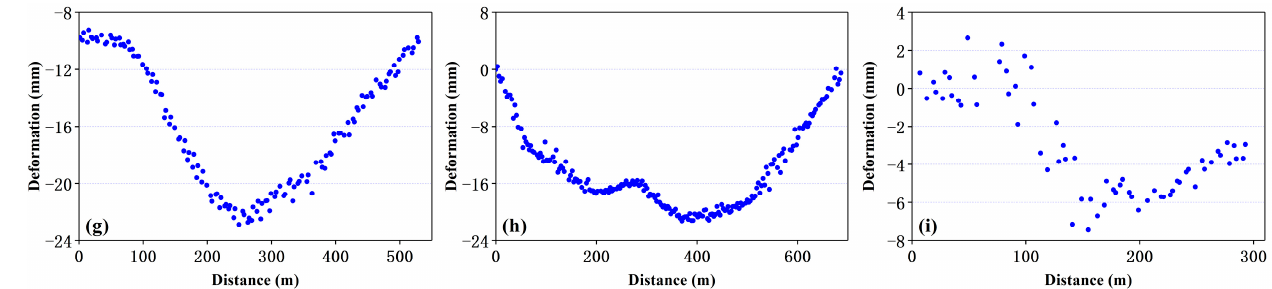
Figure 9. Land deformation rate and time series of three subsidence area. ( a – c ) is Santa Ana Basin, Pomona–Ontar Basin, and San Bernardino Basin; ( d – f ) Corresponding time series of deformation center; ( g – i ) the result of deformation rate that is extracted along the profile.